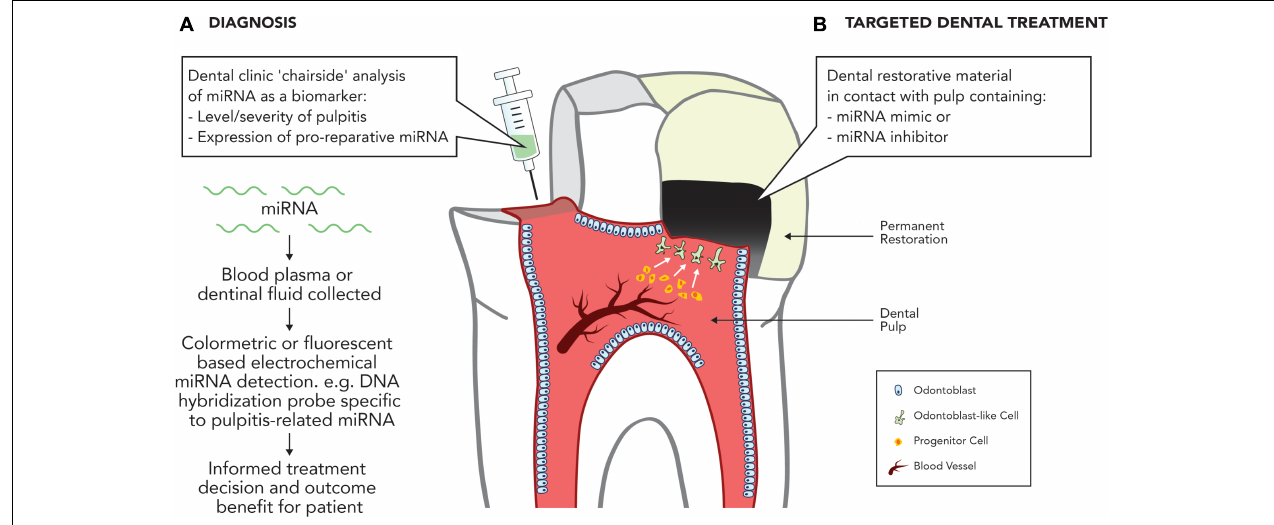
FIGURE 2 | Potential applications of miRNA in treating the inflamed pulp. (A) Diagnosis. Development of dental ‘chairside’ analytic techniques to reliably identify inflammatory associated mRNA in pulpal blood. (B) Targeted therapy. Use of miRNA inhibitors or mimics to stimulate dental pulpal repair